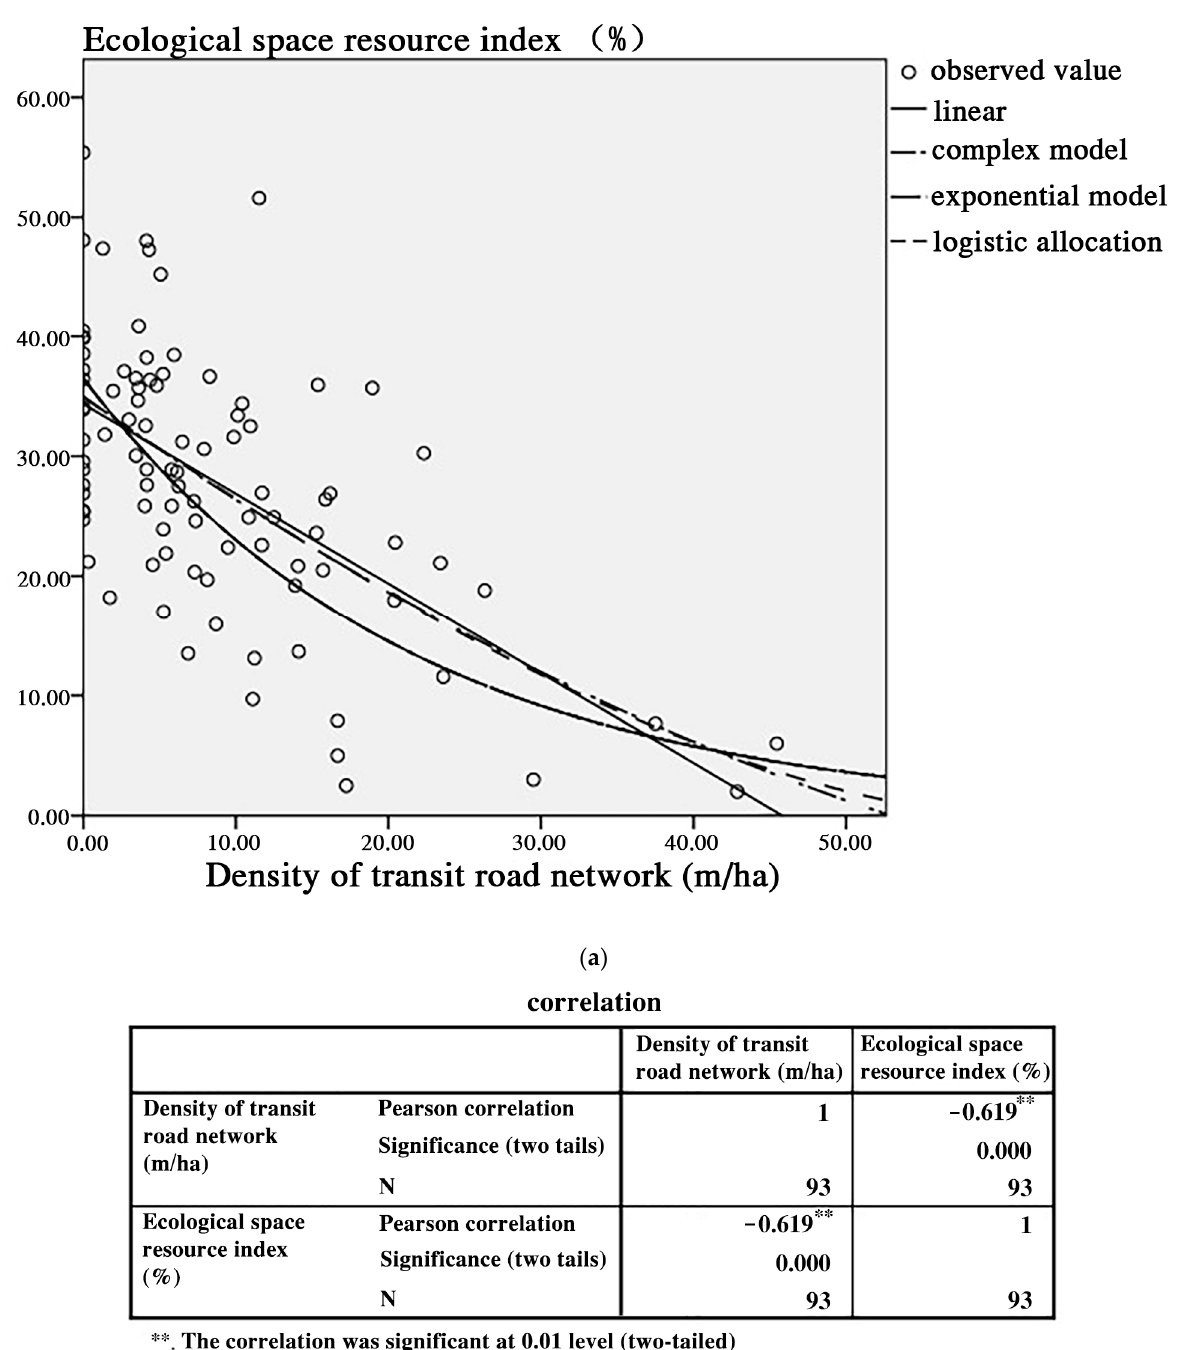
Figure 9. ( a ) Equation fitting analysis of the transit road density and the ecological space resource index (source: self-drawn). ( b ) Correlation analysis between the transit road density and the ecological space resource index (source: self-drawn).